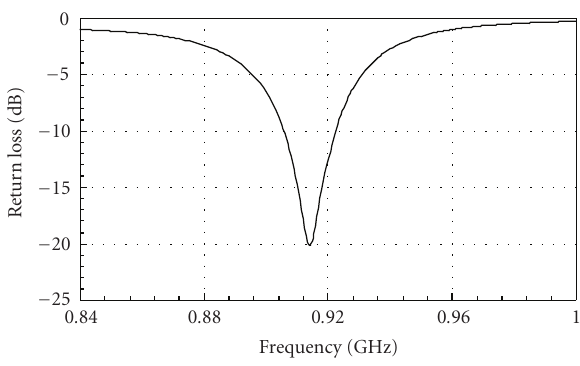
Figure 11: Simulated return loss.